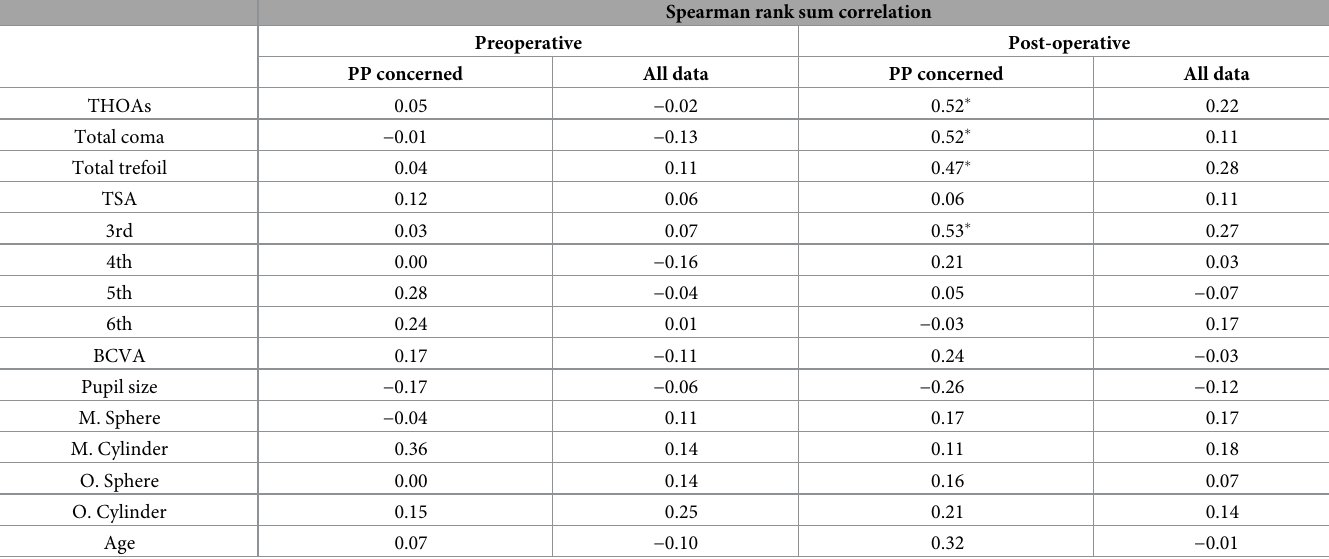
Table 3. Statistical correlations between subjective photophobia scores and RMS of wavefront and other clinical parameters.